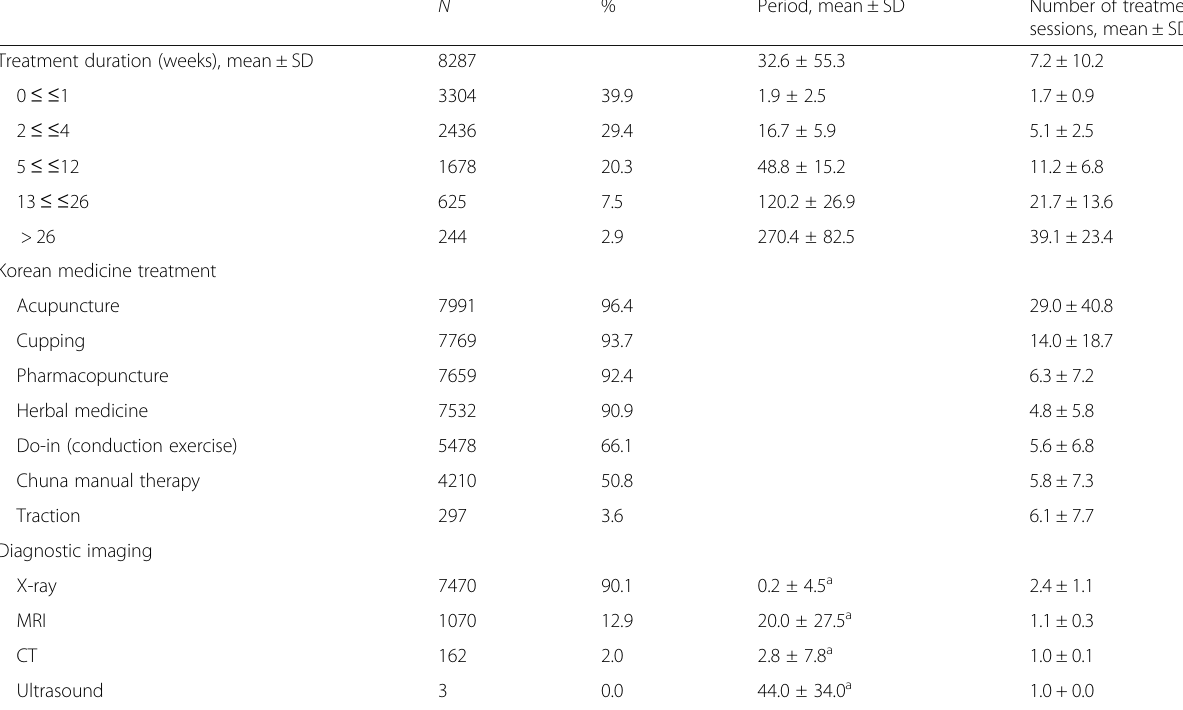
Table 3 Treatment duration, diagnostic imaging and Korean medicine service use of traffic accident patients